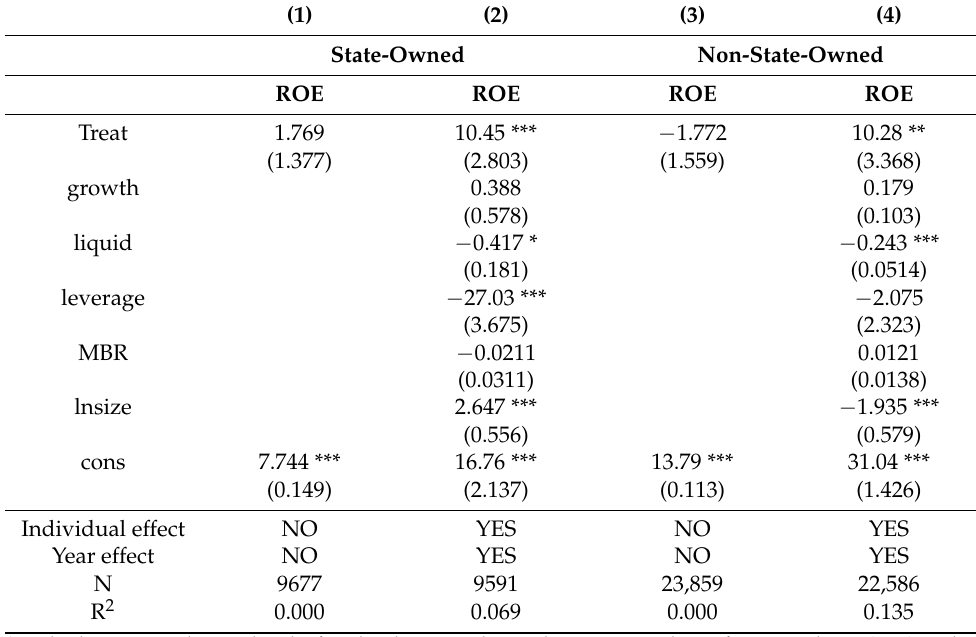
Table 8. Results of ownership